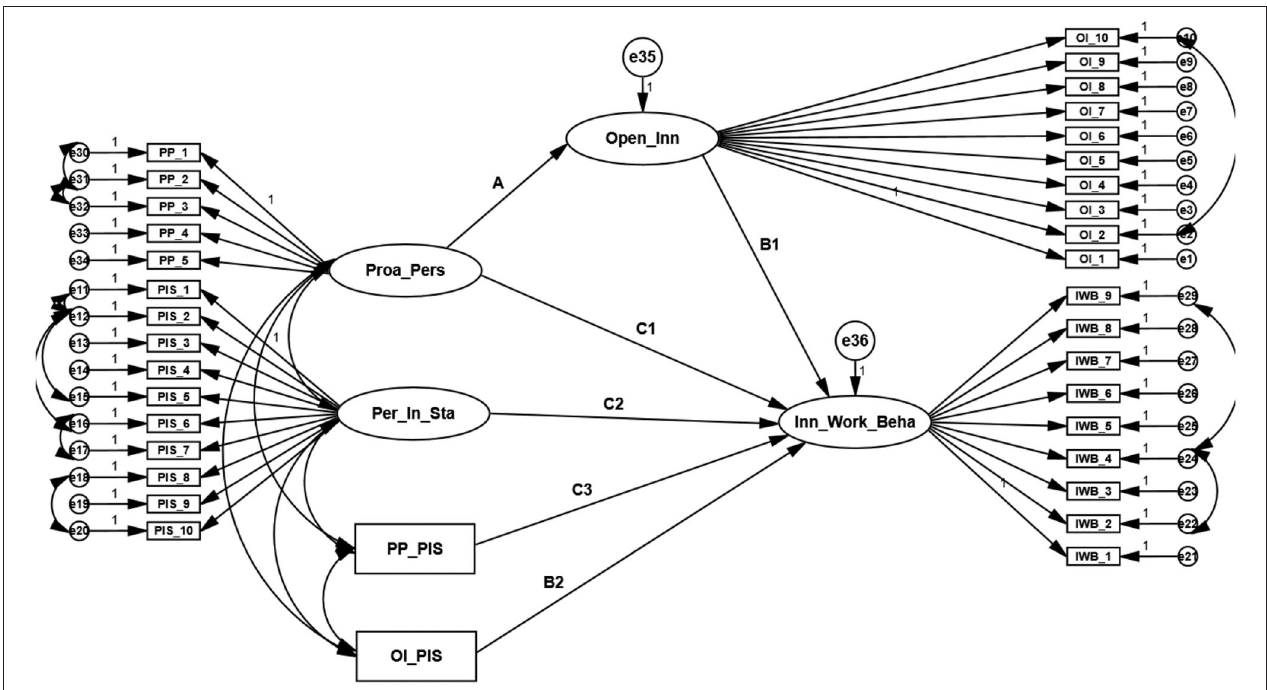
FIGURE 2 | Structural model. Source: generated through AMOS.